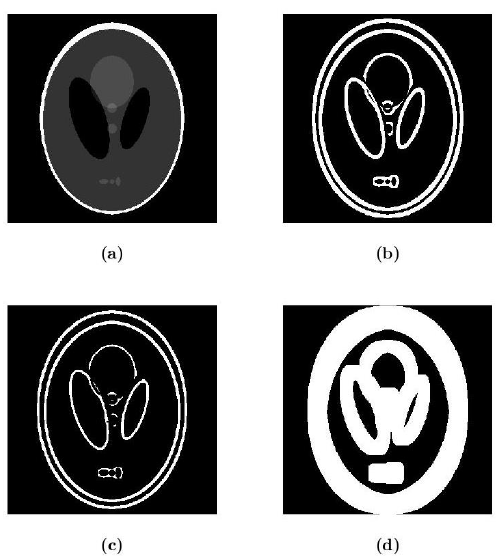
Figure 5. The process of determining the RoI. ( a ) Original Shepp–Logan phantom. ( b ) After LoG filter and binarization. ( c ) Image erosion of ( b ). ( d ) Image dilation of ( c ).